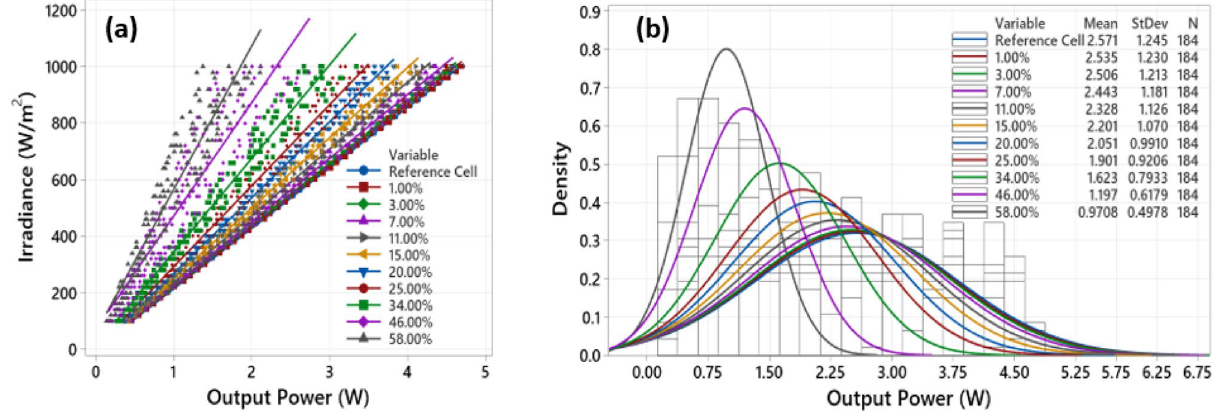
Figure 5. ( a ) Output power vs irradiance for the examined solar cells, ( b ) Density and the calculated parameters of the collected data; N = 184 represents the number of samples of every